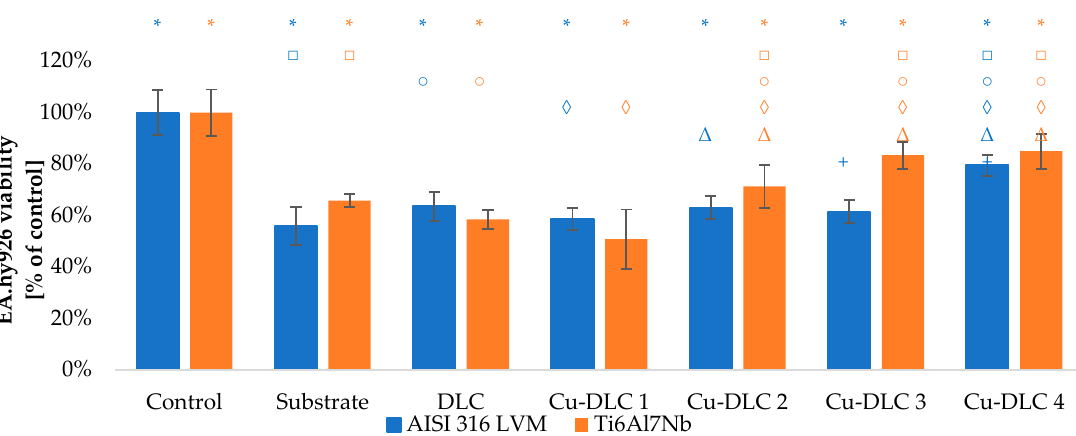
Figure 13. Evaluation of viability of EA.hy926 cell on the surface of Ag-DLC coatings deposited on AISI 316LVM and Ti6Al7Nb (live/dead test). Total number of cells expressed as a percentage of control.